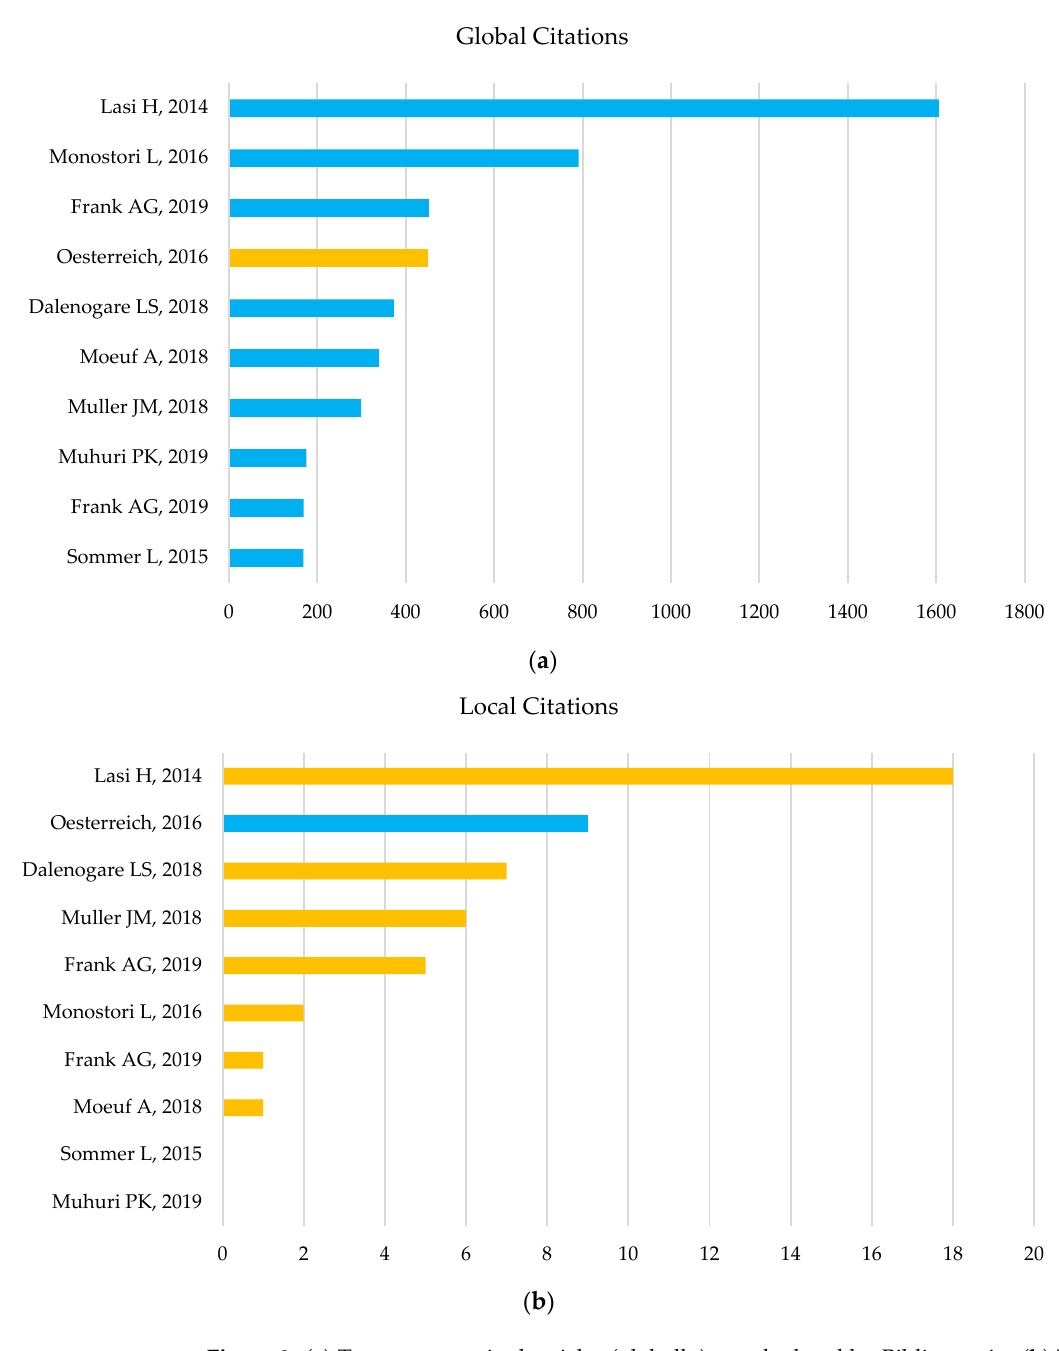
Figure 2. Top ten most relevant authors as calculated by Bibliometrix.